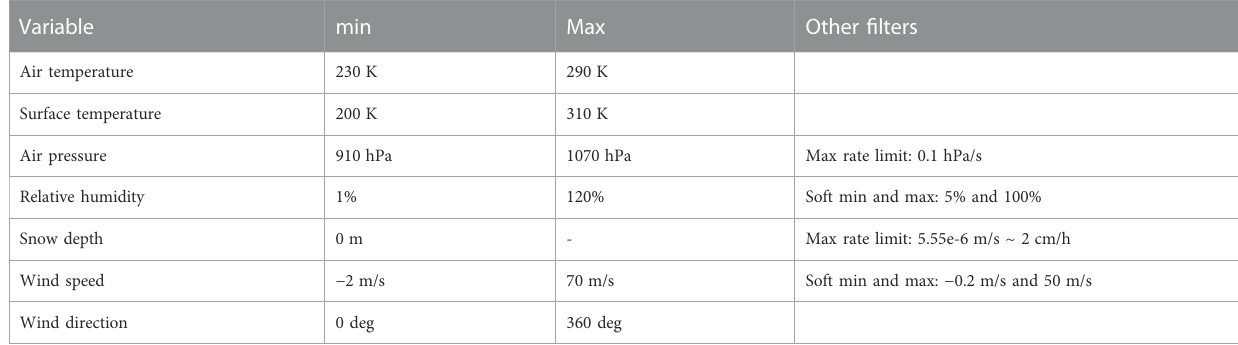
TABLE 2 Summary of data quality-control rules for nodes deployed in the region of Ny